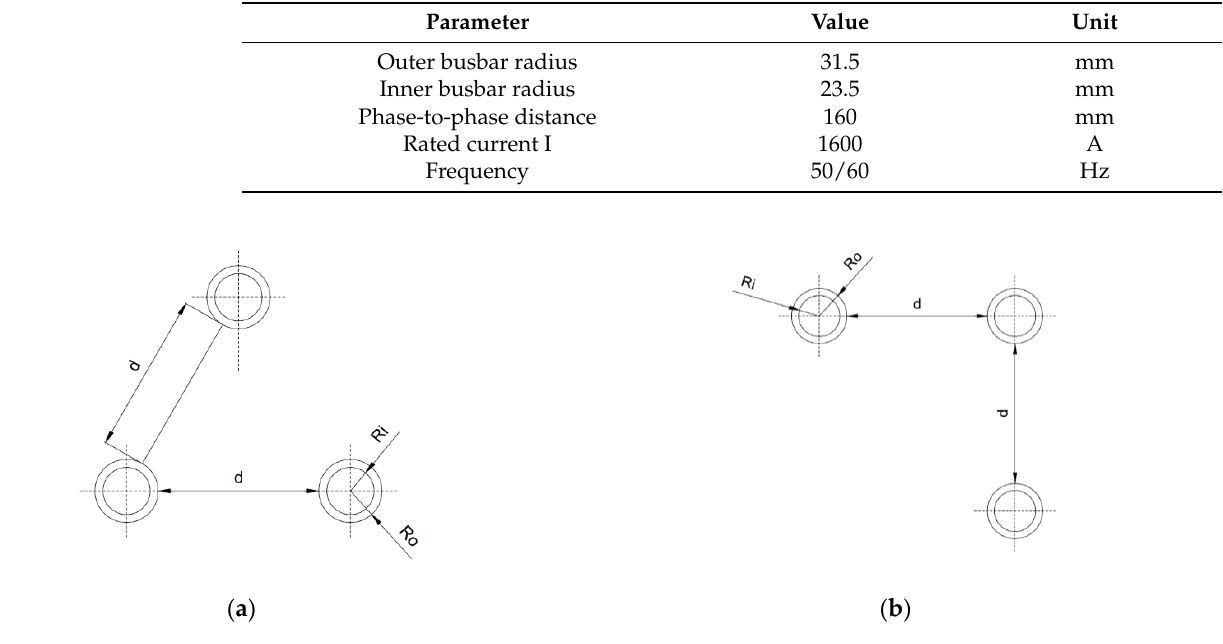
Figure 10. Layout of: ( a ) Model 5; ( b ) Model 6.